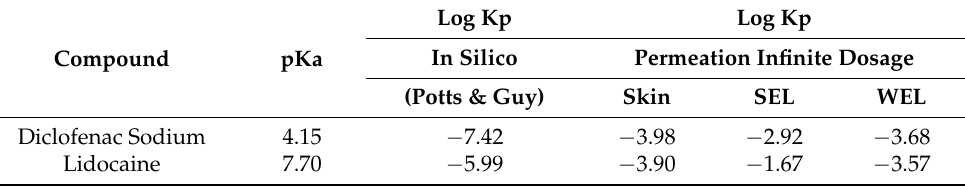
Table 5. The pKa, log Kp in silico, log kp in vitro from the experimental kinetic